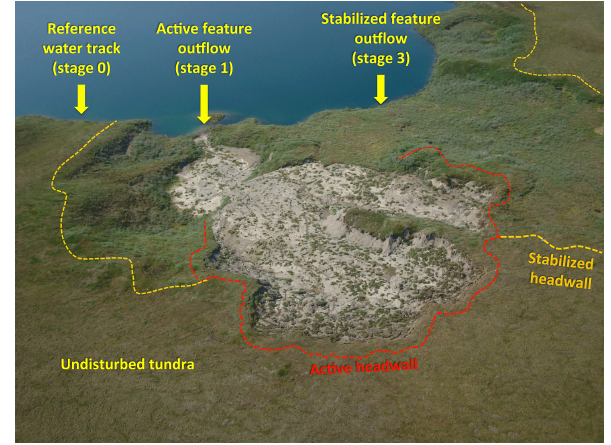
Figure 3. Aerial view of thaw slumps in various development stages. Samples were collected from feature outflows and adjacent water bodies such as unimpacted water tracks, streams, and lakes to assess the impact of thermokarst on water